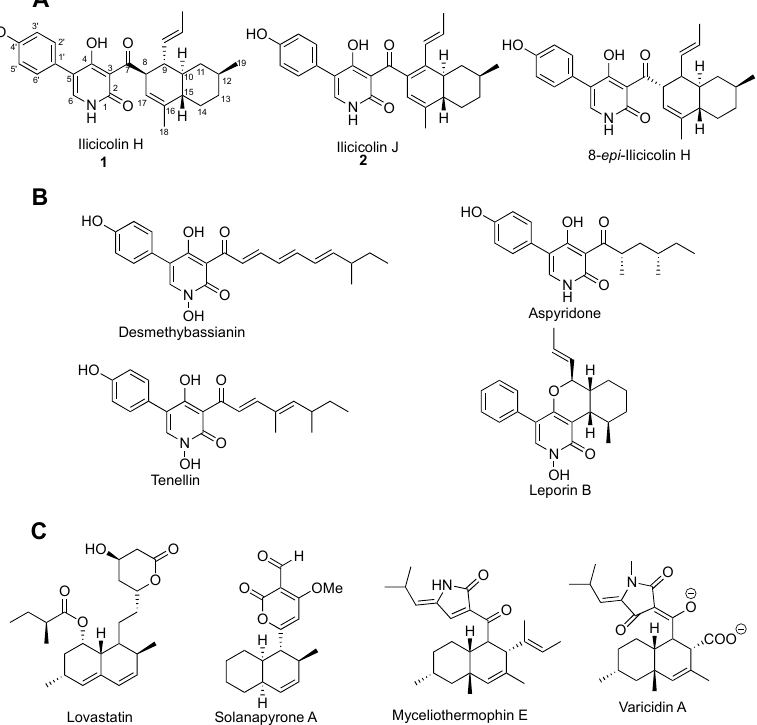
Figure 1. ( A ) Structure of ilicicolin H, ilicicolin J, and 8- epi -ilicicolin H. ( B ) Natural products containing 2-pyridone moiety. ( C ) Natural products containing decalin moiety.